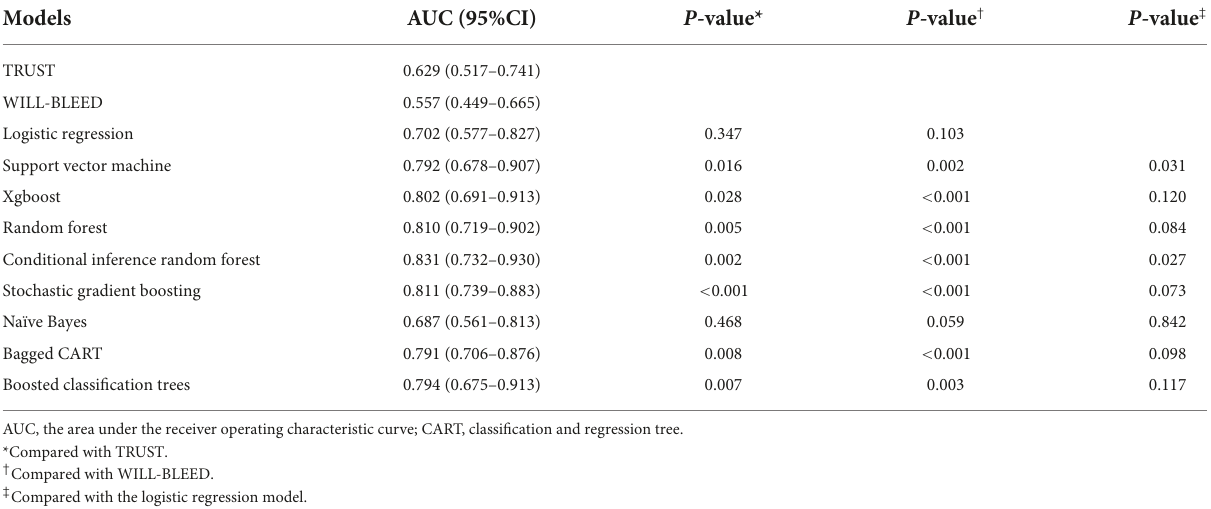
TABLE 3 Prediction models of postoperative major bleeding in the test